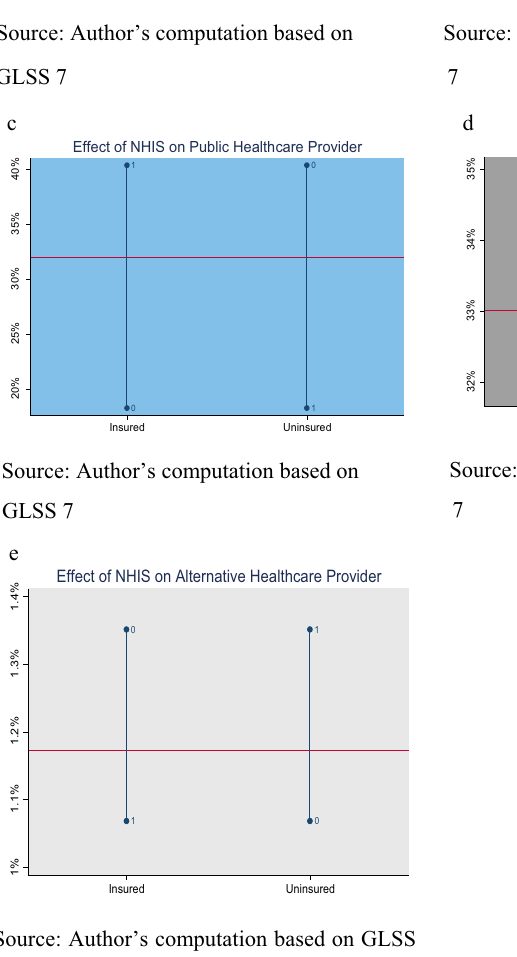
for treated (insured) and controls (uninsured) in each block. The test of balancing properties indicates that the balancing property is satis fi ed. This means that in each of these blocks, not only are the propensity scores similar, but the background characteristics on which the matching is done are also similar.